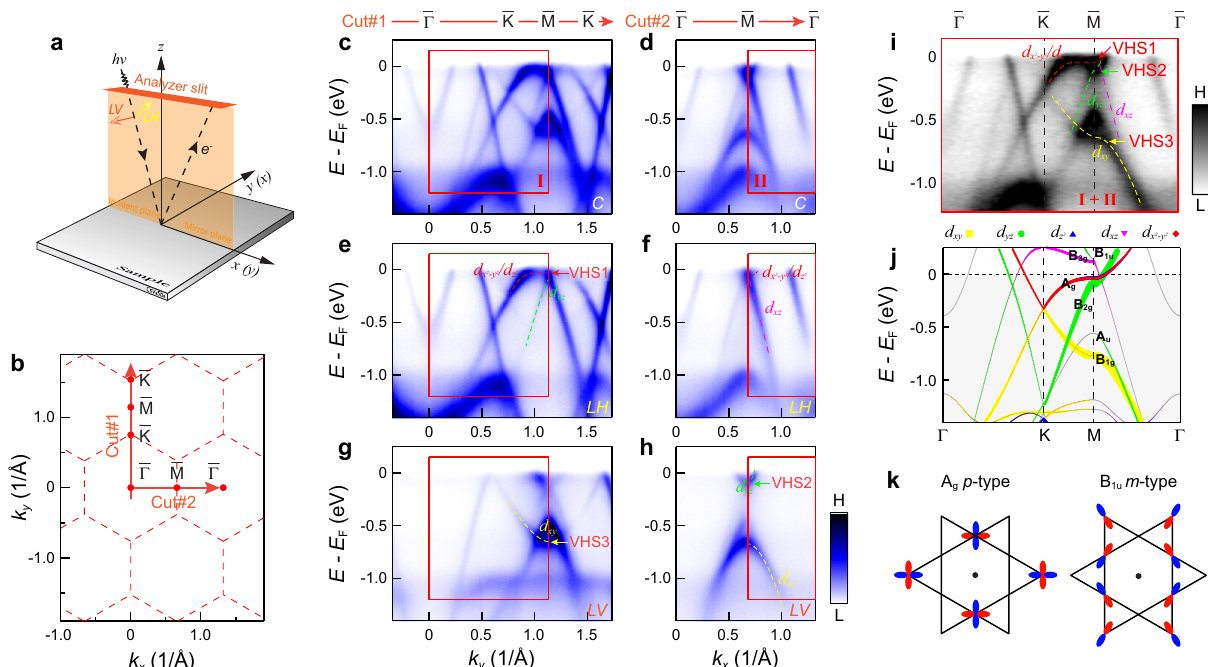
Fig. 3 Determination of the orbital nature the kagome bands in CsV 3 Sb 5 . a Experimental geometry of our polarization-dependent ARPES. b The two- dimensional projection of the Brillouin zone and the high-symmetry directions. c , d Band dispersions along the (cid:1) Γ - (cid:1) K - (cid:1) M - (cid:1) K [Cut#1, ( c )] and (cid:1) Γ - (cid:1) K - (cid:1) Γ [Cut#2, ( d )] directions, respectively. The momentum directions of the cuts are indicated by the red arrows in ( b ). The bands were measured with circularly polarized light, at 200 K. e , f and g , h Same as ( c , d ), but probed with linear horizontal (LH) ( e , f ) and linear vertical (LV) ( g , h ) polarizations, respectively. We note that the intensity of the fl at-top dispersion around the (cid:1) M point is weakened in ( e ), which may be due to the matrix element effects (see Supplementary Fig. 7 for the details of the matrix element analysis for the higher-order VHS band). i Experimental band structure along the (cid:1) Γ - (cid:1) K- (cid:1) M- (cid:1) Γ direction, with orbital characters marked. The momentum range is equal to the sum of the region I in ( c ) and region II in ( d ) selected by the red box. The dispersion is the same as the cut shown in Fig. 2c. j Orbital character resolved band structure from the A sublattice in the calculations, with irreducible band representations labeled. k The sign structure (blue/red) and spatial orientation of the d x 2 (cid:2) y 2 -orbital A g p-type (inversion-even) and d xz -orbital B 1u m-type type (inversion-odd) VHS. The phase orbitals are plotted in the positive k z plane. The black dots in the center of the hexagons indicate the inversion